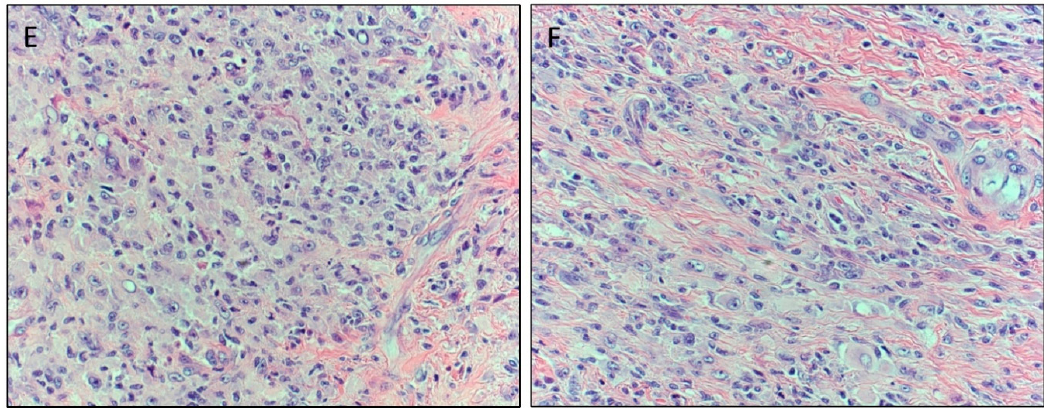
Figure 2. Spectrum of histomorphologic features of atypical tenosynovial giant cell tumors (TGCTs) in Case 2 ( A – C ) and Case 3 ( D – F ). ( A ) Mid-power magnification showing a cellular neoplasm with a predominance of mononucleated cells with scattered multinucleated osteoclast-like cells with intervening fibrous stroma (original magnification × 20). ( B ) Areas showing hyperchromatic pleomorphic nuclei and spindling. No necrosis was seen (original magnification × 40). ( C ) High-power magnification demonstrating multinucleated giant cells with symplastic changes in addition to increased cellular atypia in the mononuclear cell population consistent with the rendered diagnosis of atypical component within the tumor (original magnification × 40). ( D ) Photomicrograph of more benign-appearing areas composed of multinucleated giant cells and sheets of epithelioid histiocytoid cells arranged in a syncytial pattern (original magnification × 20). ( E ) Areas showing presence of larger pleomorphic nuclei with open chromatin and prominent nucleoli (original magnification × 40). ( F ) Scattered areas of cells with enlarged nuclei, spindle cells, and cells with virocyte-like nucleoli conferring worrisome morphology (original magnification ×